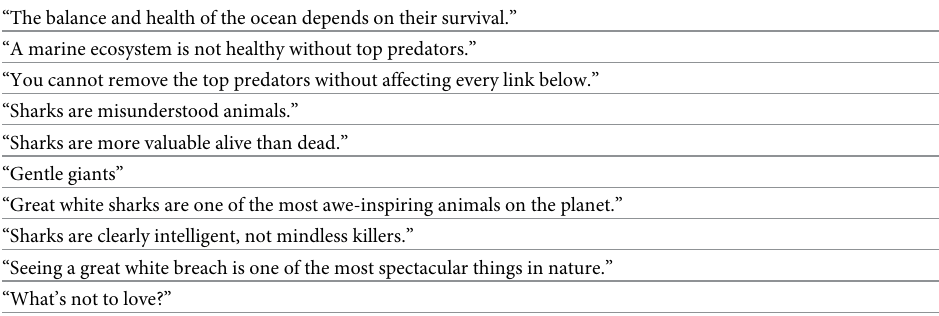
Table 2. Representative example dialogue and narration showing sharks in a positive light. “The balance and health of the ocean depends on their survival.” “A marine ecosystem is not healthy without top predators.” “You cannot remove the top predators without affecting every link below.” “Sharks are misunderstood animals.” “Sharks are more valuable alive than dead.” “Gentle giants”